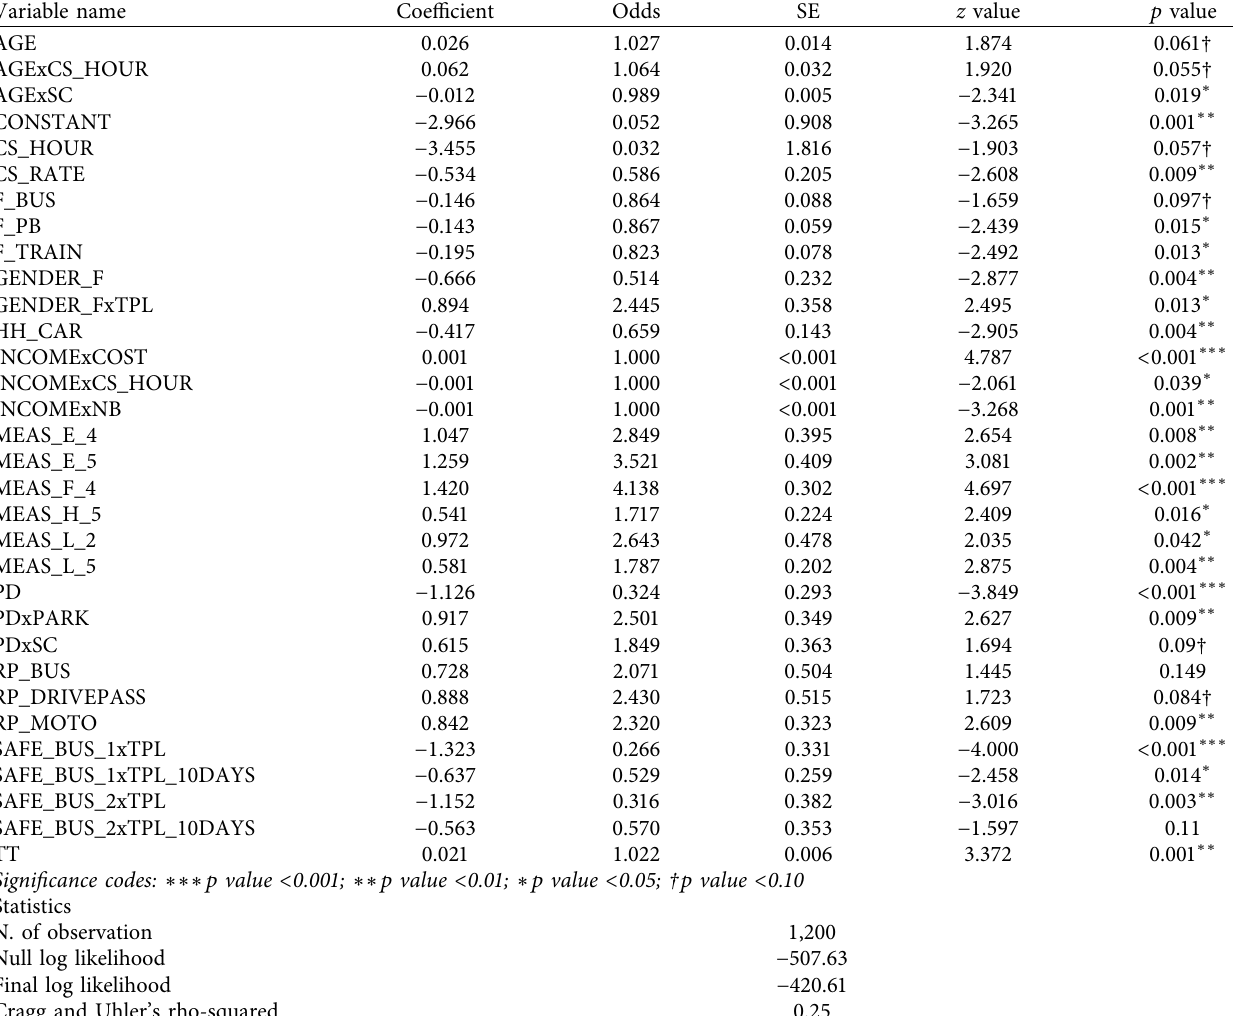
Table 7: MaaS adoption-estimated parameters and model